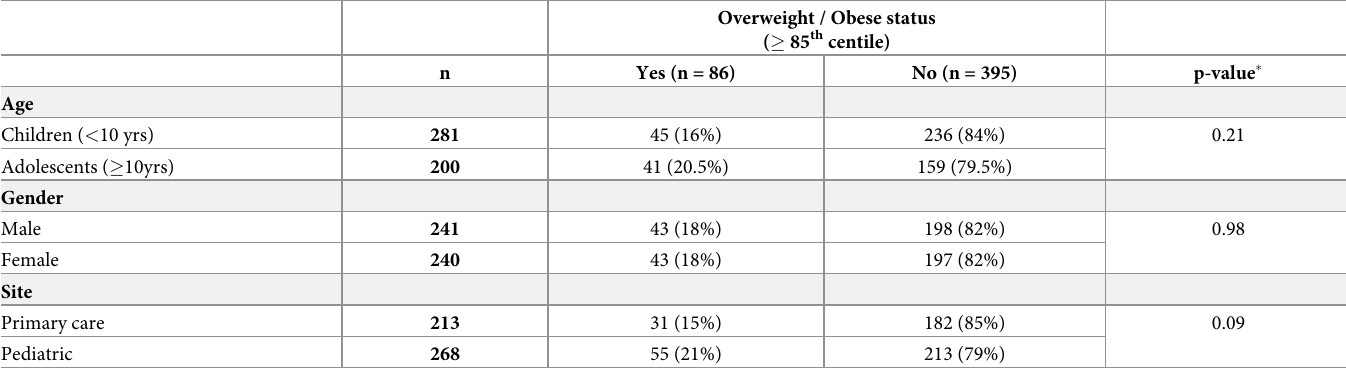
Table 3. Distribution of overweight/obese status patients by covariates.